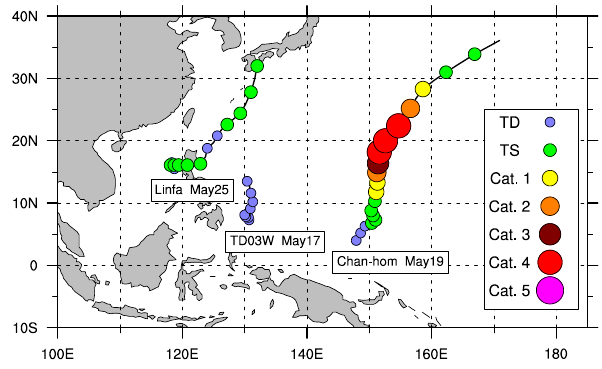
Fig. 1. TC tracks occurring near the location and time of onset of the modeled Kelvin and Yanai wave combination according to “Best Track” estimates. Colored circles denote storm intensity according to the Saffir–Simpson intensity scale (TD – Tropical Depression, TS – Tropical